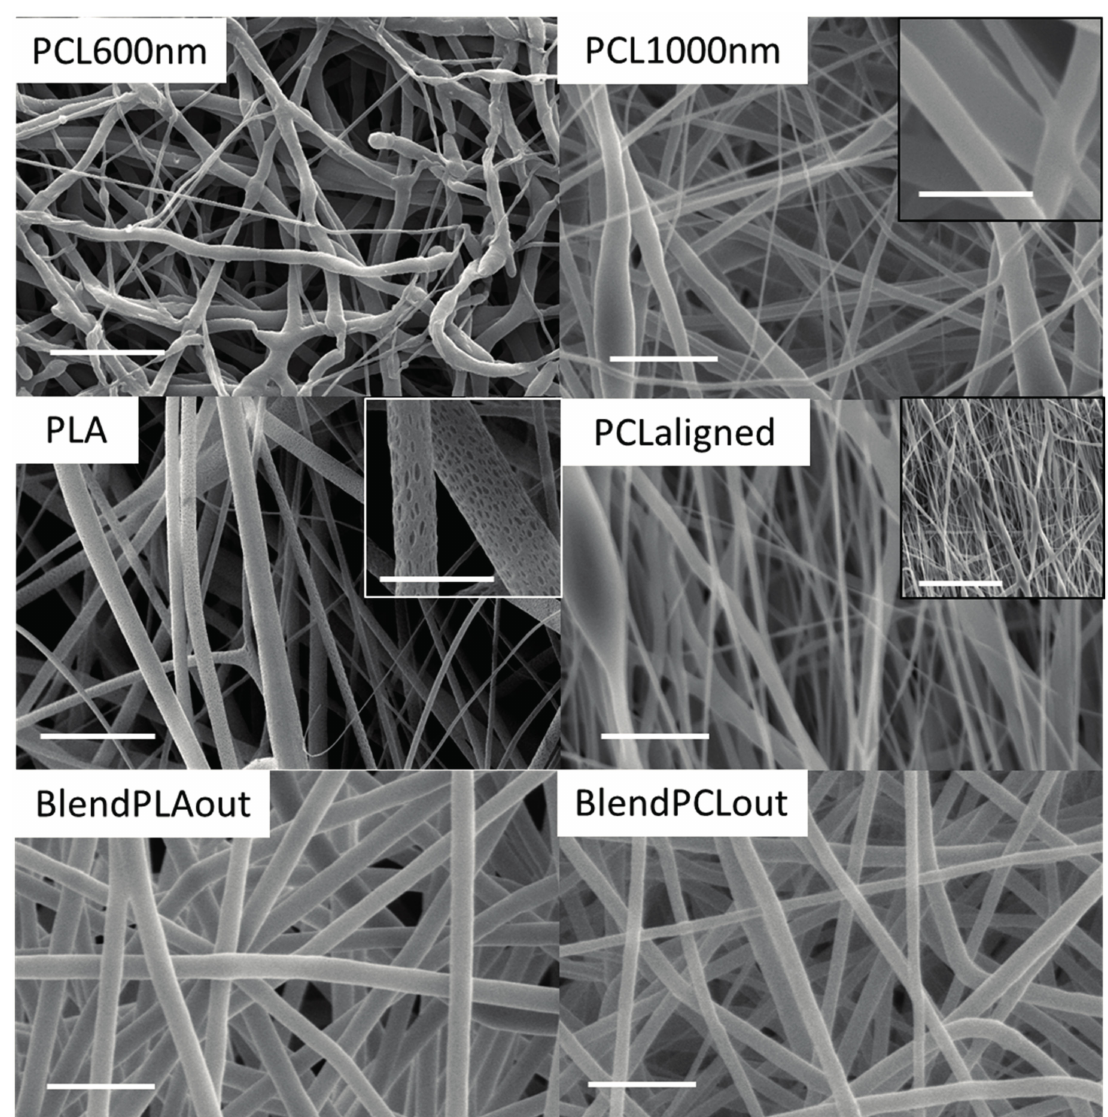
Figure 2. Scanning Electronic Microscopy (SEM) observations of the electrospun scaffolds. Insets in PLA, PCL1000nm and PCL-aligned panels: SEM observation of the PLA and PCL1000nm scaffolds to highlight porosity at the fiber scale, and of the PCL-aligned scaffold to highlight alignment. Main scale bars: 10 µ m, PLA inset: 2 µ m, PCL1000nm inset: 4 µ m, PCL-aligned inset: 50 µ